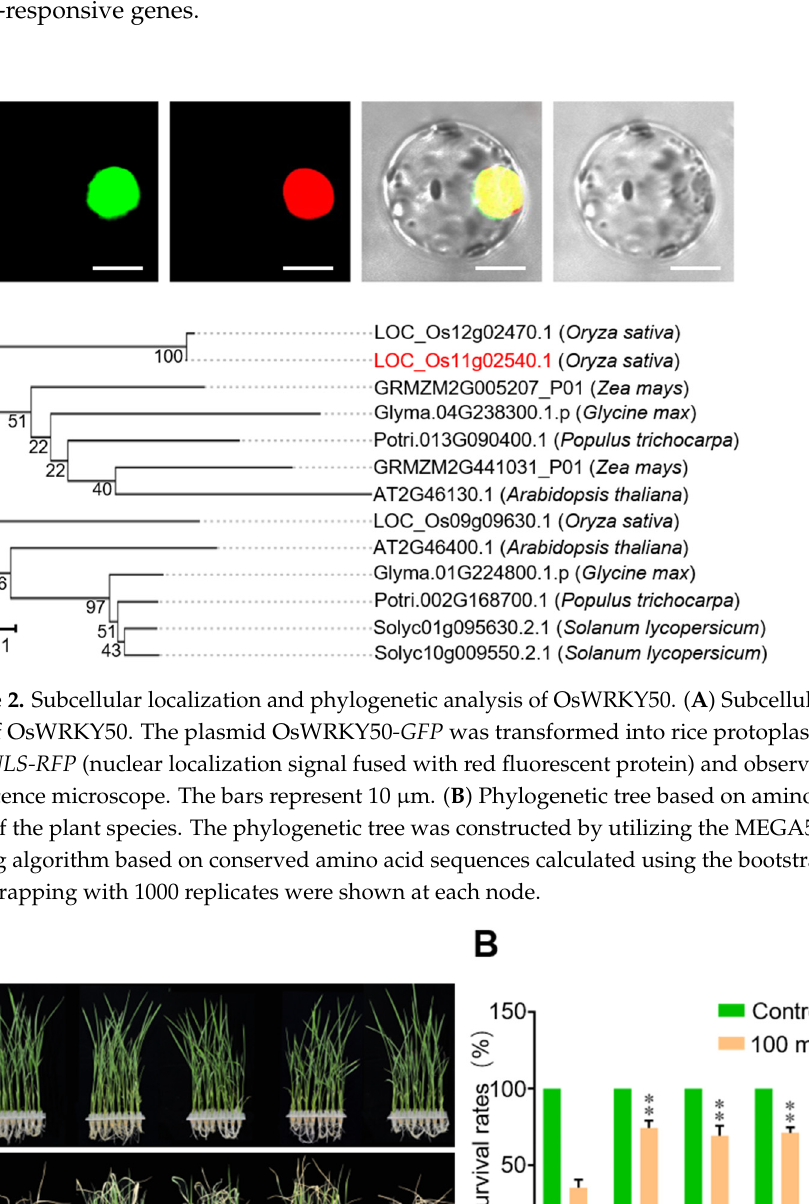
Figure 3. Phenotypes of KT, OX ‐ 1, OX ‐ 2, OX ‐ 3, and EV plants. ( A ) Two ‐ week ‐ old rice seedlings from KT, OX ‐ 1, OX ‐ 2, OX ‐ 3, and EV plants were treated with 100 mM NaCl for seven days and recovered for three days. ( B ) The survival rates under salt stress were measured according to ( A ). Error bars indicate ± SD ( n = 3). ** p ‐ value < 0.01 (Student’s t ‐ test).